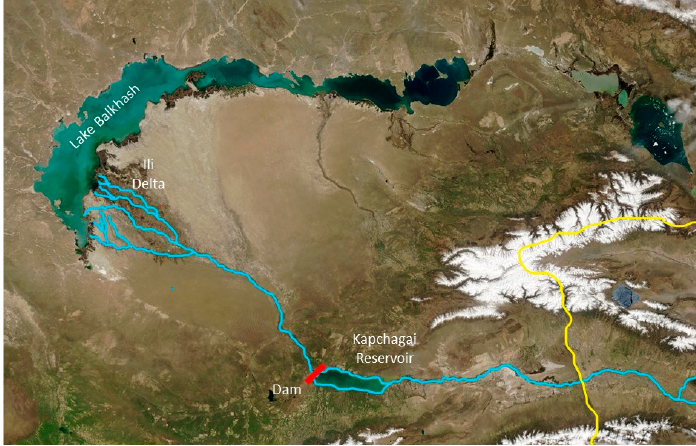
Figure 4. The Ili River ecosystem, including Kapchagay Reservoir, the delta, and Lake Balkhash. The yellow line marks the Kazakhstan – China border.